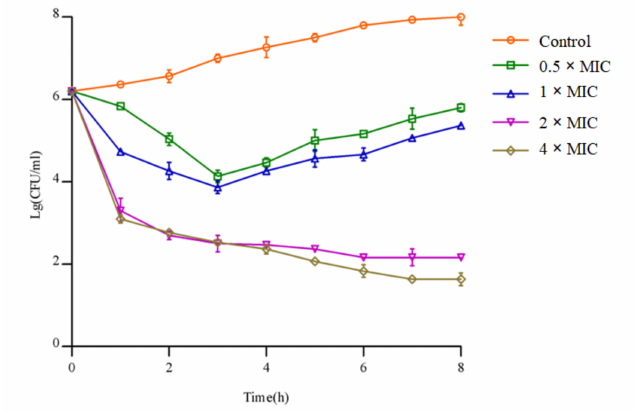
Figure 3. Bactericidal activity of pantocin wh-1 against M. smegmatis mc 2